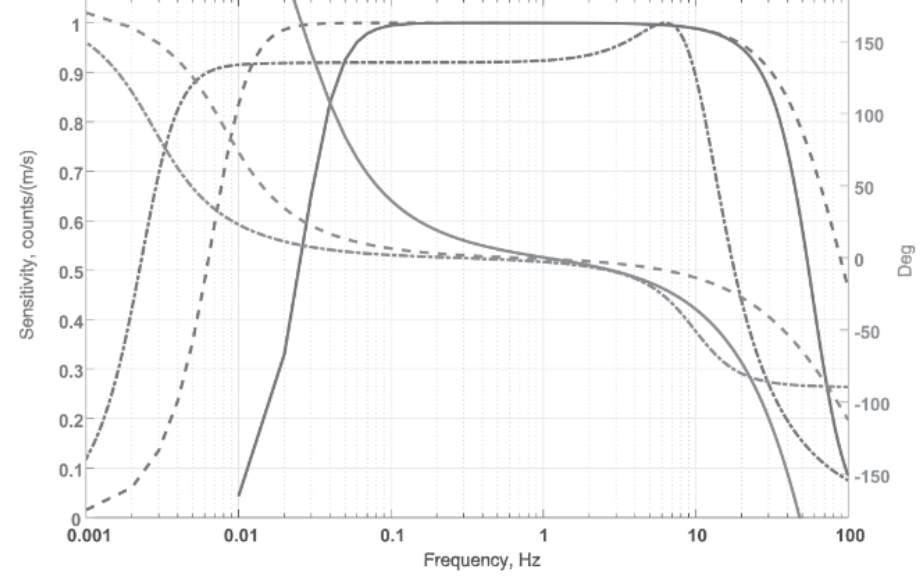
Figure 2. Typical amplitude-frequency response (AFR) and phase-frequency response (PFR) of Streckeisen STS-1V / VBB (dash-dotted line), Güralp CMG-3ESP (dotted lines), and CME-4211V (solid lines) devices.